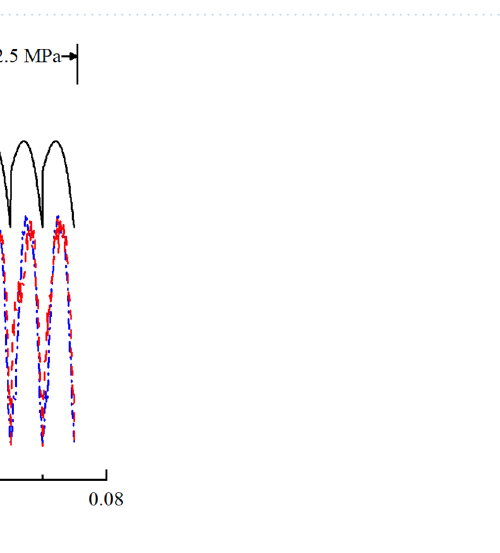
Figure 33. Comparisons of numerically and experimentally obtained volumetric efficiency